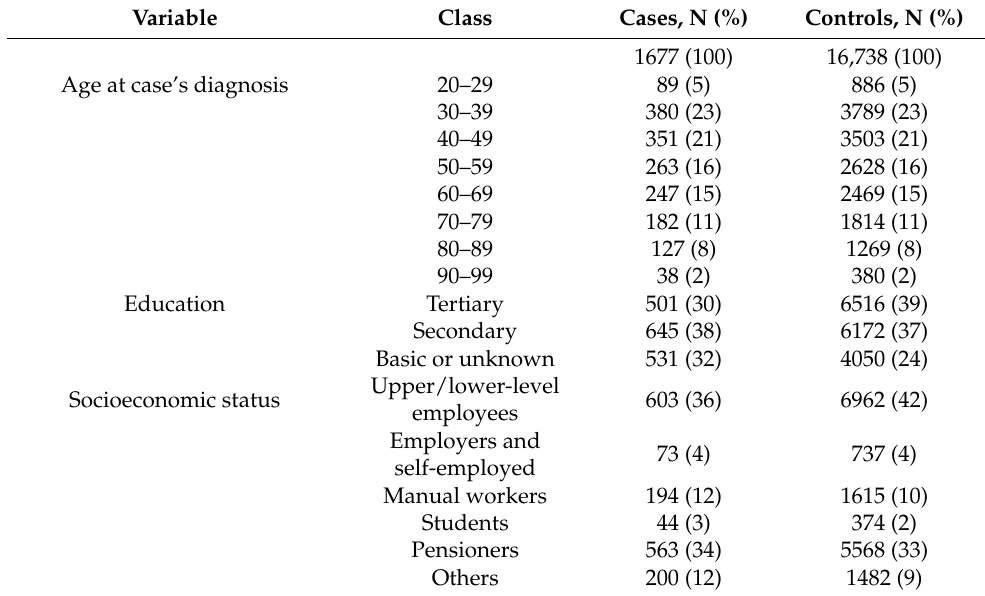
Table 1. Characteristics of the study sample.